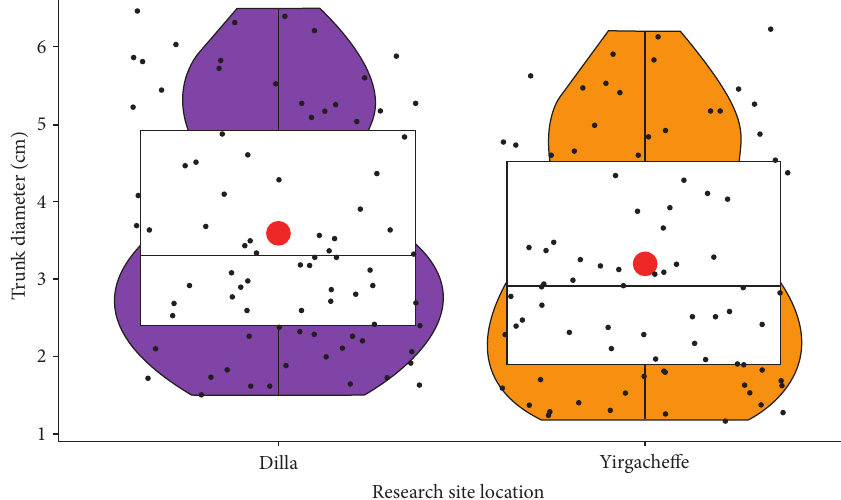
Figure 5: Grapevine trunk diameter in different growth locations.